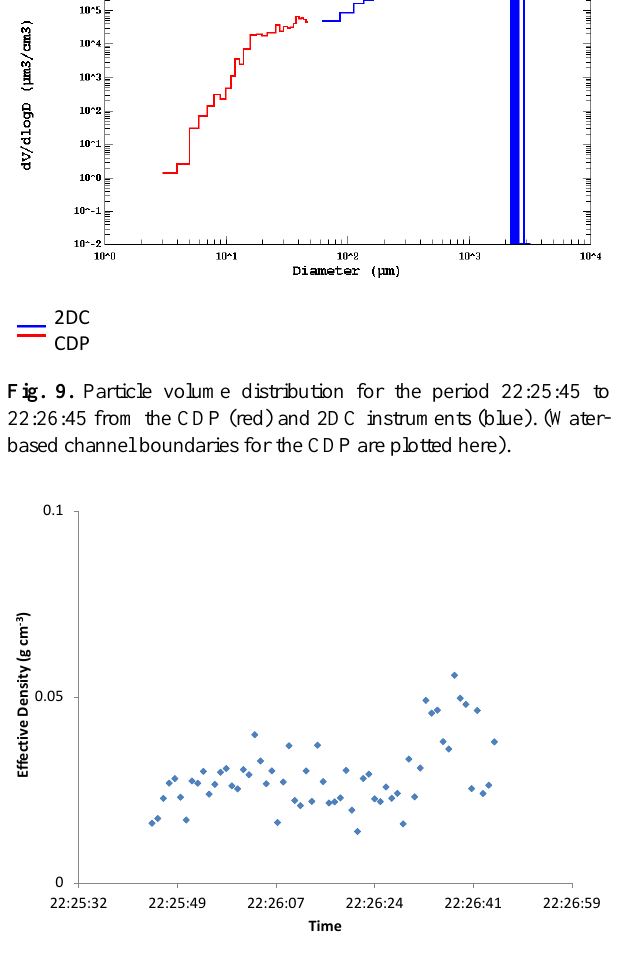
Fig. 10. Effective density of the ice inside the inscribed circle used to compute a size from the 2DC imagery. The average density is 0.029gcm − 3 .